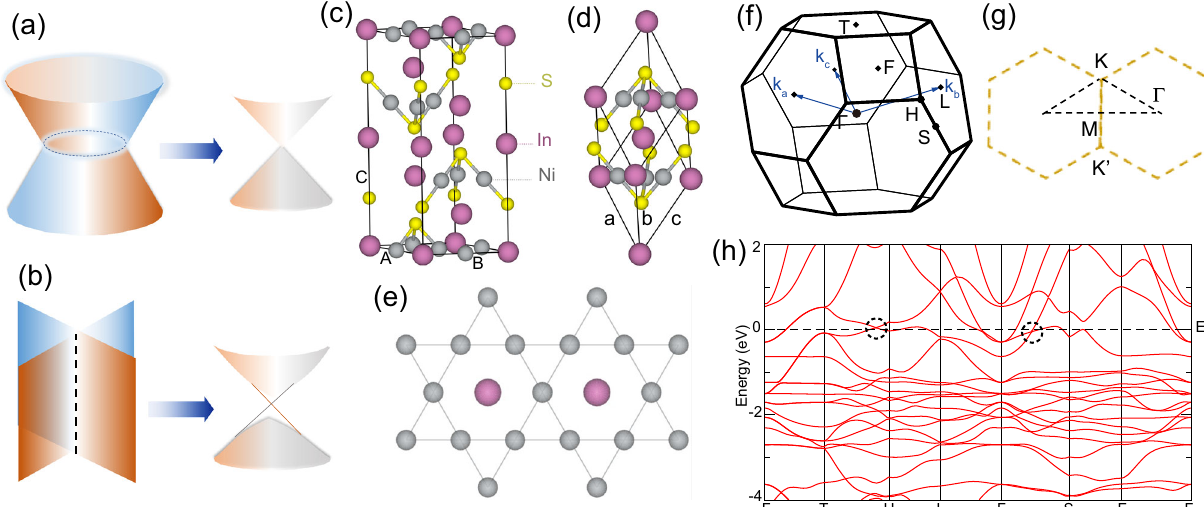
Fig. 1 Crystal structure and electronic band structure for Ni 3 In 2 S 2 . a Weyl/Dirac points that can be obtained from nodal ring band crossings in the kagome lattice by tuning parameters like magnetism, spin – orbit coupling and breaking crystalline symmetries. b Topological (crystalline) insulator states obtained from nodal line band crossing after considering spin – orbit coupling. c , d Conventional cell and primitive cell for the kagome-lattice material Ni 3 In 2 S 2 . e Kagome layer in Ni 3 In 2 S 2 . f , g Three-dimensional BZ and surface BZ along z direction for Ni 3 In 2 S 2 . Throughout the manuscript, we use the primitive cell and the 3D BZ for theoretical calculations. h Spinless electronic band structure of Ni 3 In 2 S 2 along some high-symmetry lines, with band crossings near the Fermi level highlighted by dashed circles.